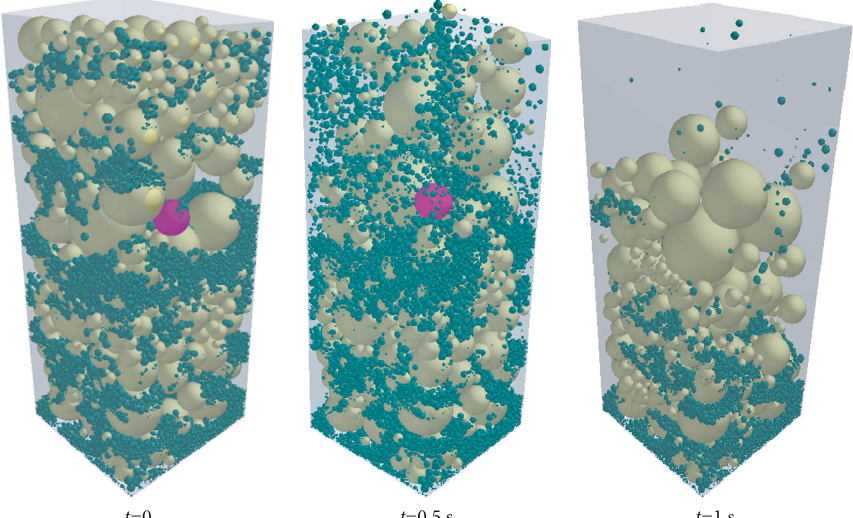
Figure 5: The trajectory of particle 1.